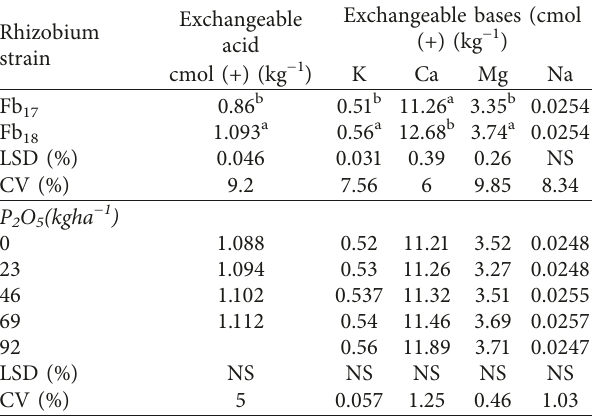
Table 5: The interaction effect of rhizobium inoculations and P fertilizer on soil organic